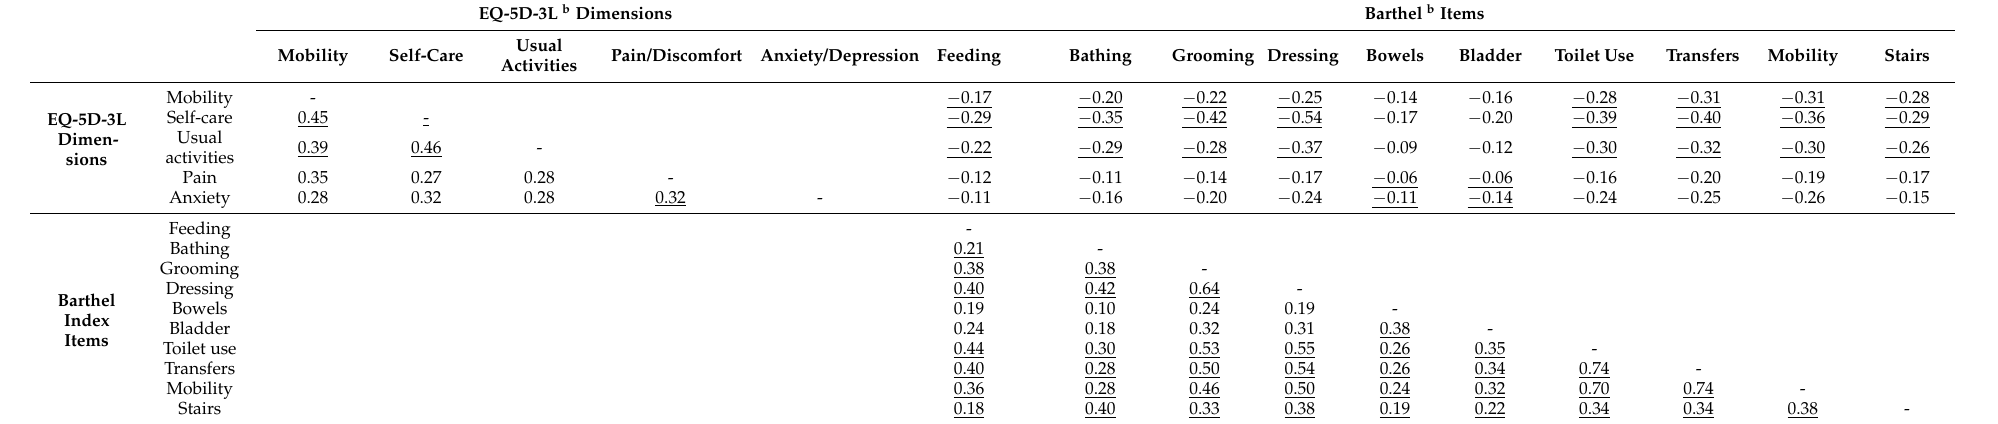
Table 3. Relationship between the descriptive classifications of the EuroQoL 5 dimensions 3 levels (EQ-5D-3L) and dimension and the item scores of the Barthel Index (BI) a : Kendall’s Tau-B rank correlation coefficients showing correlation between the EQ-5D-3L dimension and BI item scores a